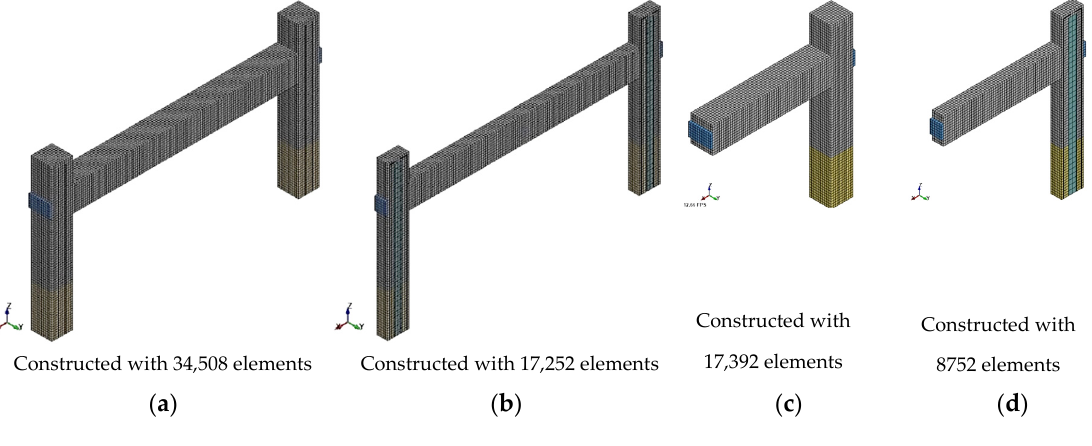
Figure 5. Specimen evolution: ( a ) Full frame; ( b ) half frame along x-dir.; ( c ) half frame along y-dir.; ( d ) quarter frame both in x- and y-dir.